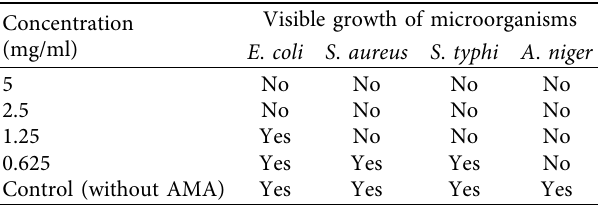
Table 2: Minimum inhibition concentration for each